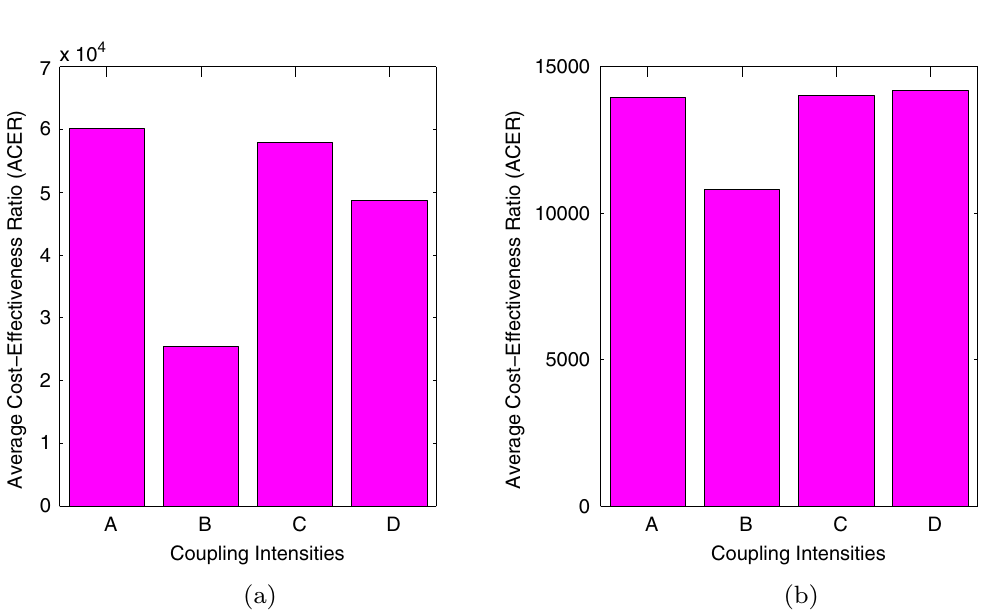
Figure 13. Graphs of ( a ) showing the average cost-effectiveness ratio (ACER) for case 1 and ( b ) showing the average cost effectiveness ratio (ACER) for case